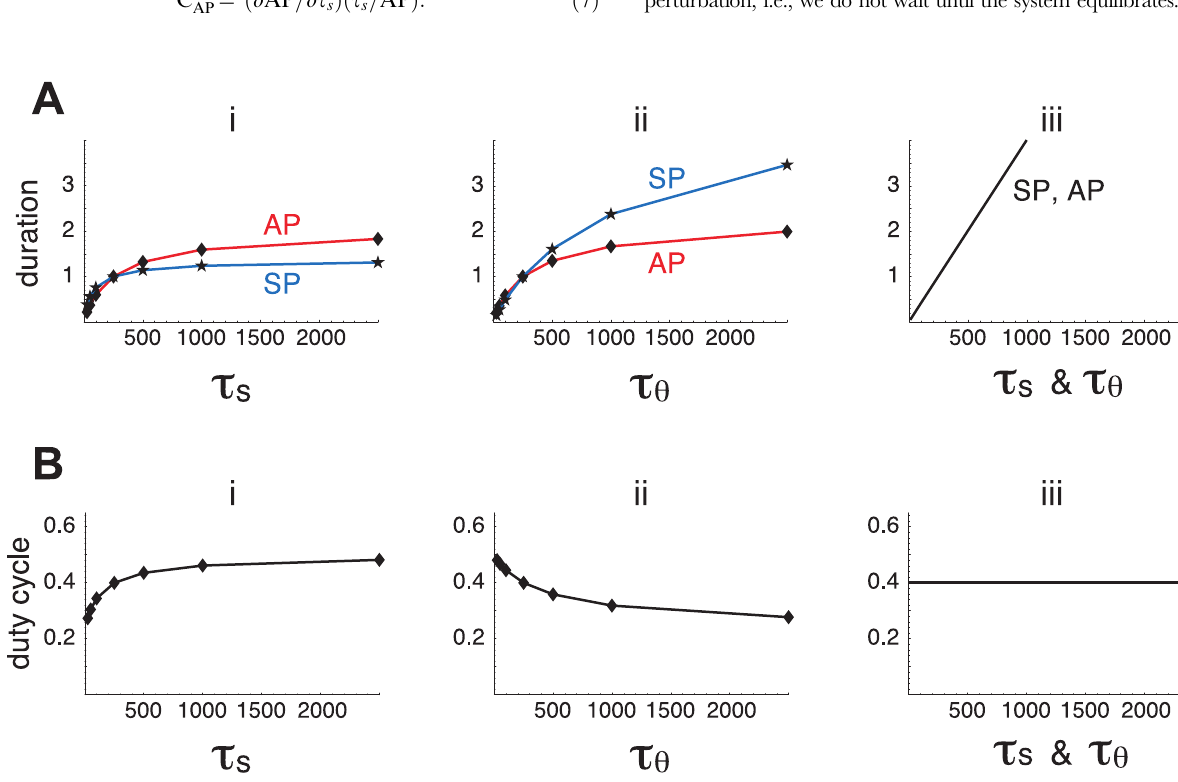
Figure 3. Variations of the time constants t s and t h have different effects on the activity pattern. A. Relative change in AP (red, diamonds) and SP (blue, stars) as t s (i) or t h (ii) is varied. For comparison, the linear change in both AP and SP when t h and t s are varied together by the same factor is shown (iii, t s & t h ). B. Variations of the duty cycle with t s (i), t h (ii) and t s & t h (iii).